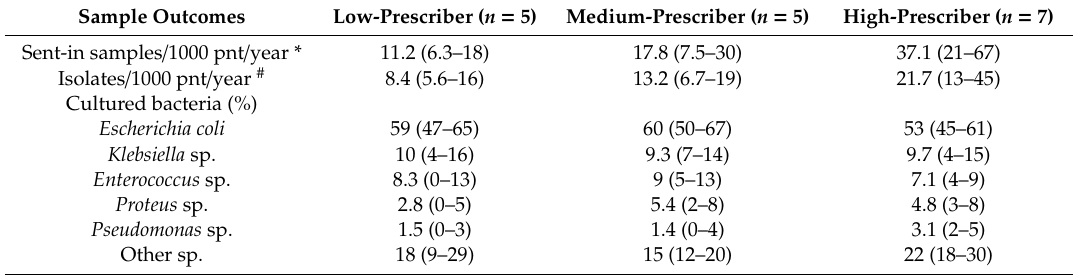
Table 2. Numbers of sent-in urine samples, isolates and cultured bacteria split per prescriber group. Sample Outcomes